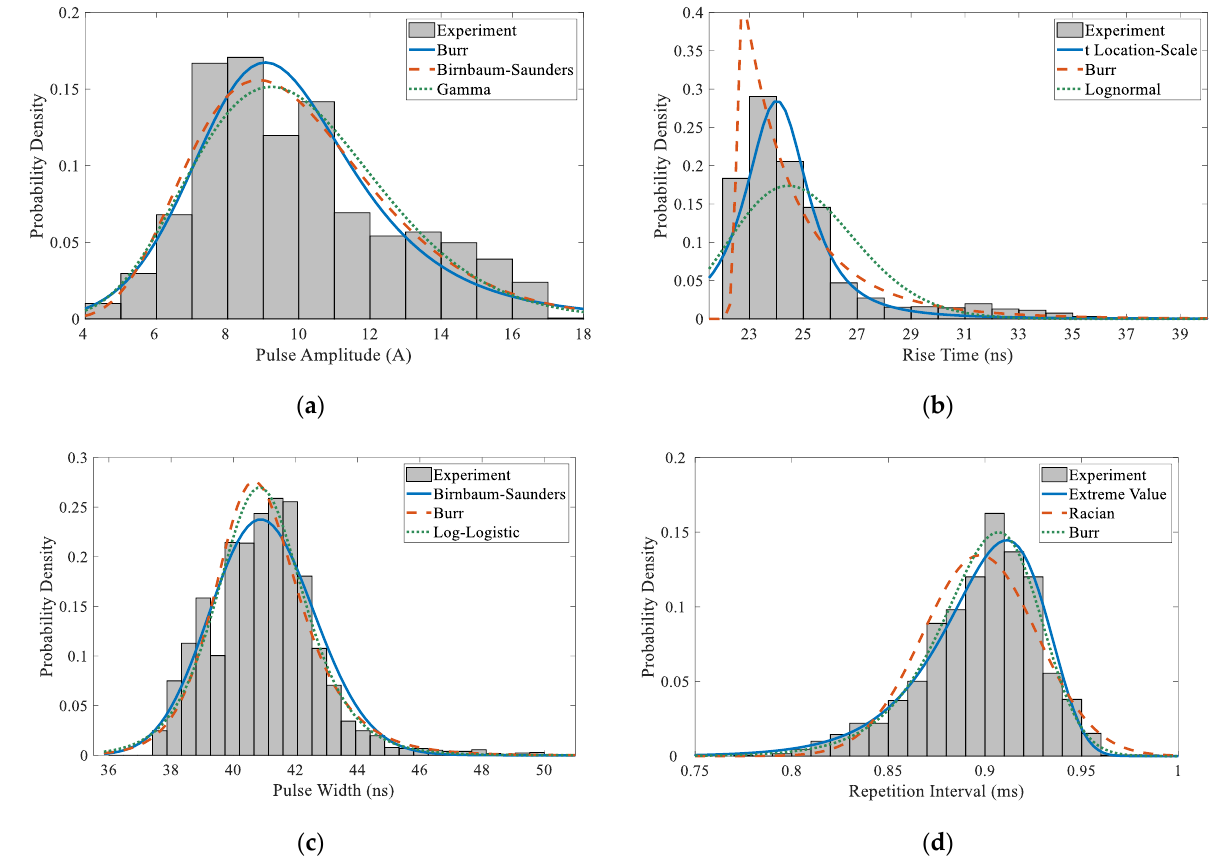
Figure 5. Distribution histogram of measured waveform parameters and theoretical reference dis- tributions: ( a ) pulse amplitude ( A + ); ( b ) rise time ( t r ); ( c ) pulse width ( t w ); ( d ) repetition interval time ( t in ).